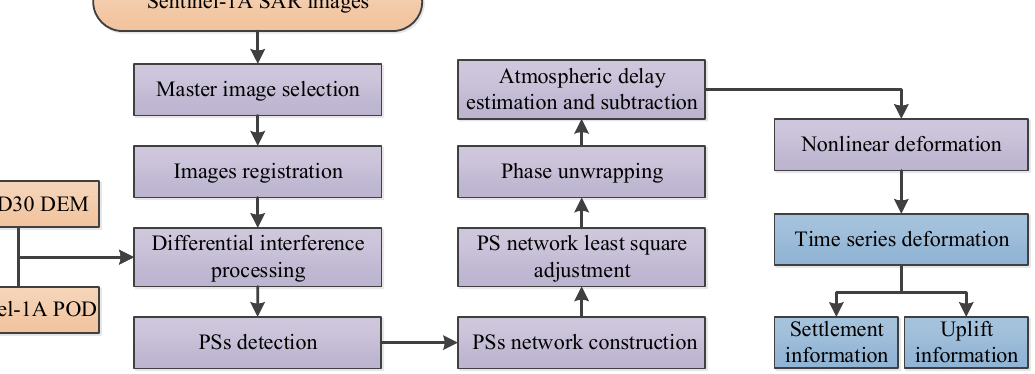
Figure 3. Flow chart of surface deformation information obtained by time series InSAR technology.